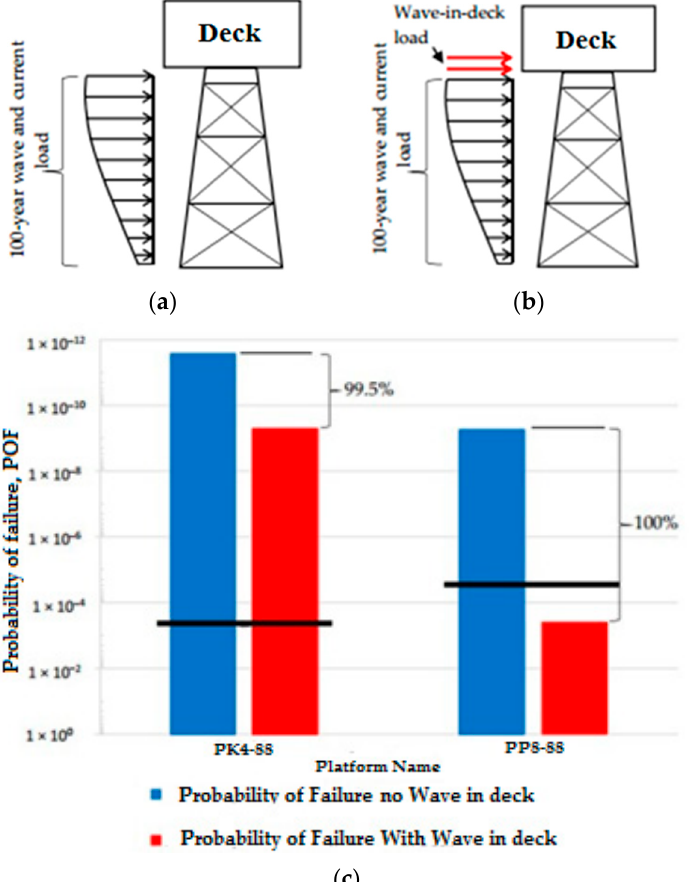
Figure 6. Comparison of the soil effect on the failure probability of two different offshore platforms [28]. ( a ) Conventional method, ( b ) Inclusion of wave-in-deck load, ( c ) Failure probability of different platforms with and without wave-in-deck load.